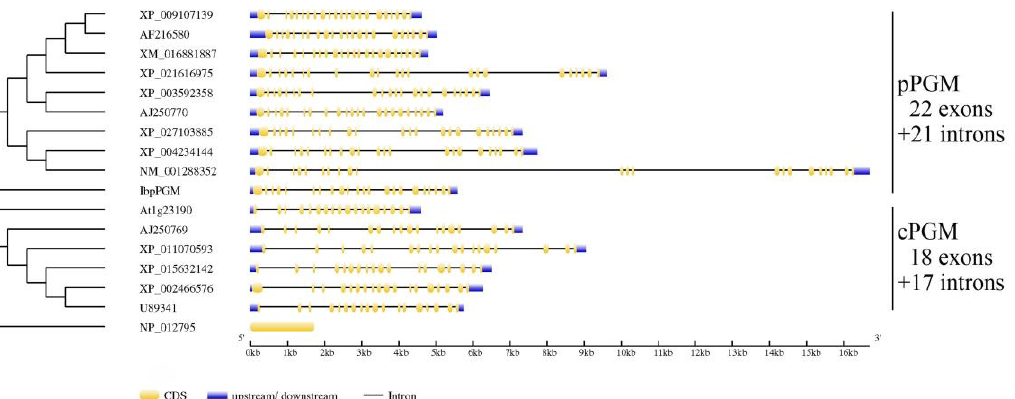
Figure 1. Multiple sequence alignment of PGM proteins. AtpPGM: Arabidopsis thaliana , AF216580; StpPGM: Solanum tuberosum , NM_001288352; PspPGM: Pisum sativum , AJ250770; AtcPGM: A. thali-